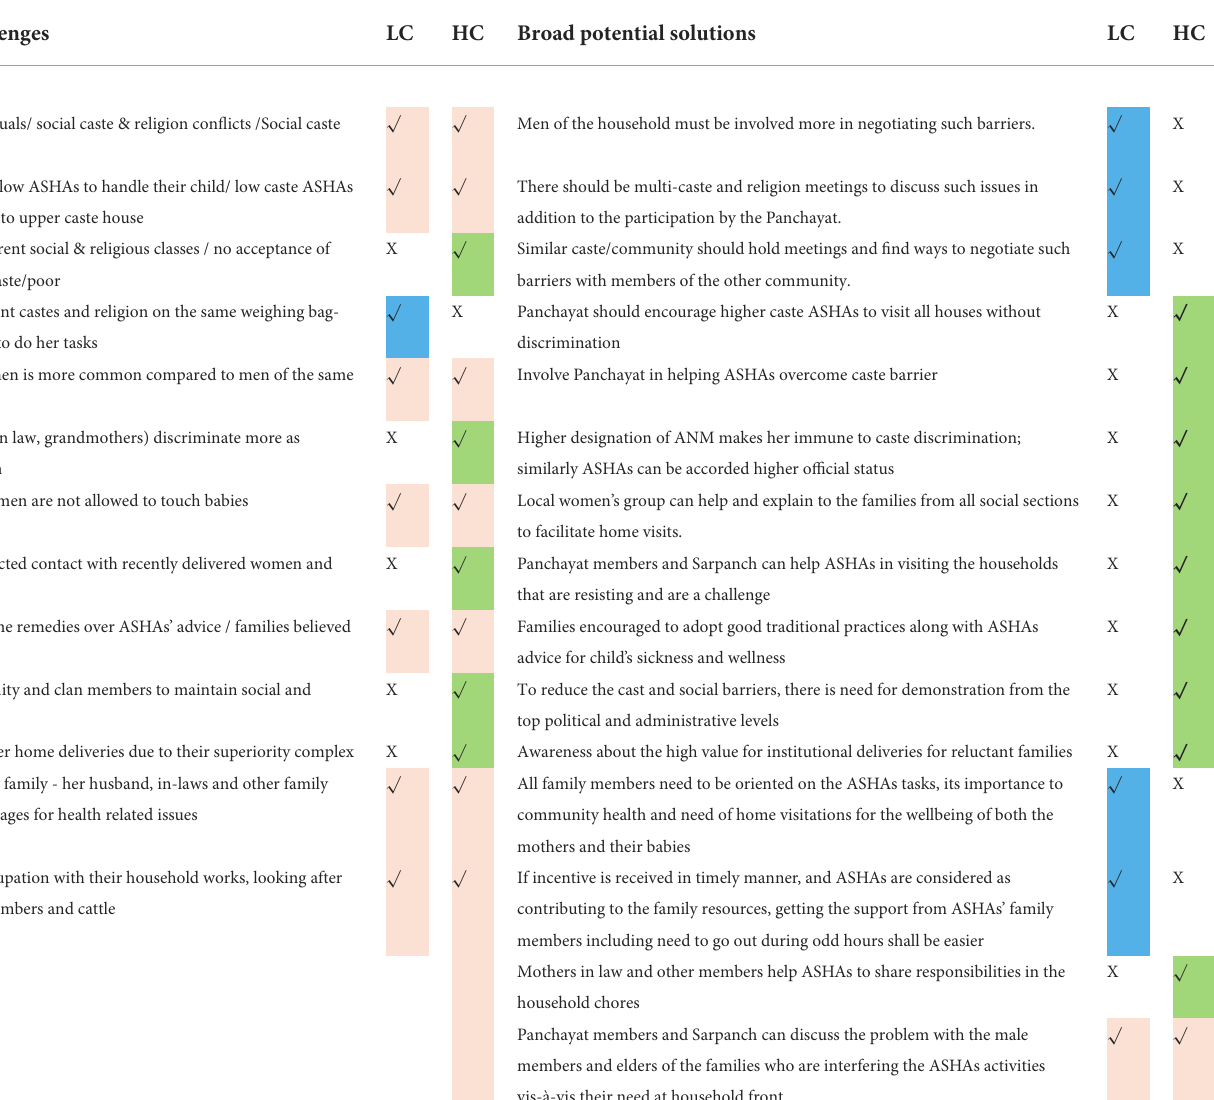
TABLE 2 Preliminary nexus planning meetings with stakeholders (community, families, parents, ASHAs) separately with the lower caste (LC) and higher caste (HC) groups: summary of issues influencing home visitation by the ASHAs under HBNC & HBNC Plus